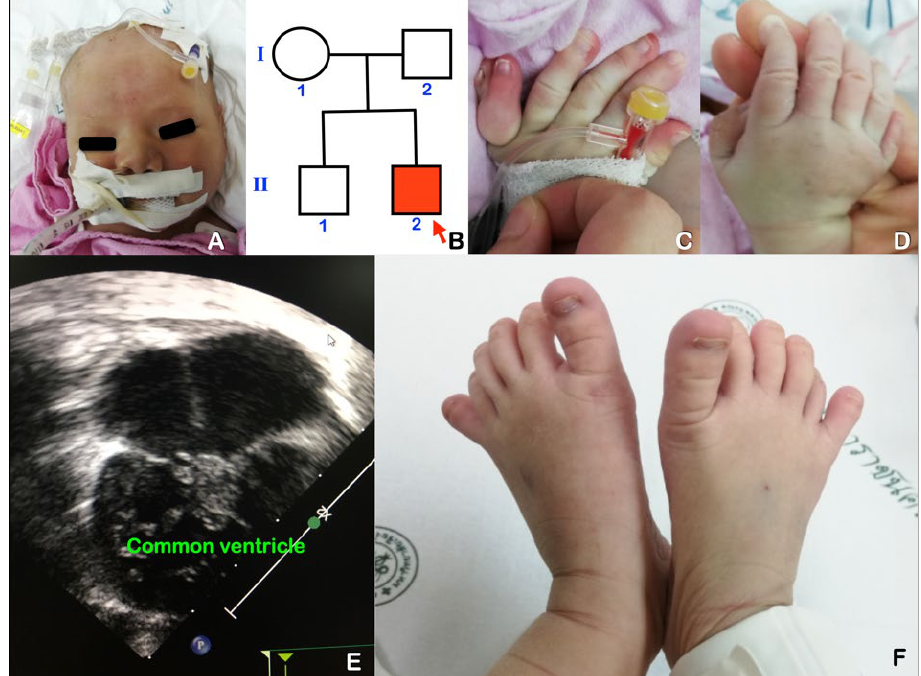
Figure 2. Patient 2 at age 1.5 months had Bardet–Biedl syndrome caused by a homozygous mutation in BBS7 . ( A ) Bulbous nose and micrognathia. ( B ) Pedigree. ( C , D ) Post-axial polydactyly of the